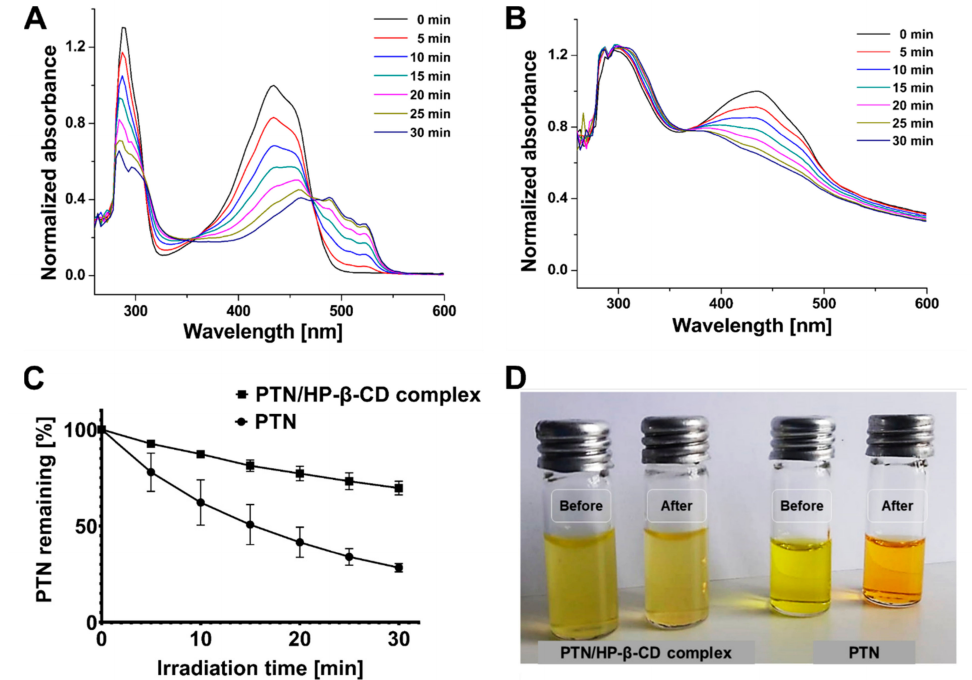
Figure 9. Effect of HP- β -CD on the photodegradation of PTN after blue LED irradiation at dif- ferent time intervals ( λ irr = 457 nm, irradiance = 220.2 W/m 2 ). ( A ) The absorption spectra of PTN in ethanol and ( B ) the absorption spectra of PTN/HP- β -CD complexes in ultrapure water. ( C ) Decrease in the PTN content of free and complexed PTN at different irradiation intervals with a blue LED. ( D ) Photomicrograph of PTN/HP- β -CD complexes and PTN before and after 30 min irradiation. All measurements were performed in triplicate, and the values were expressed as means ± SDs ( n =